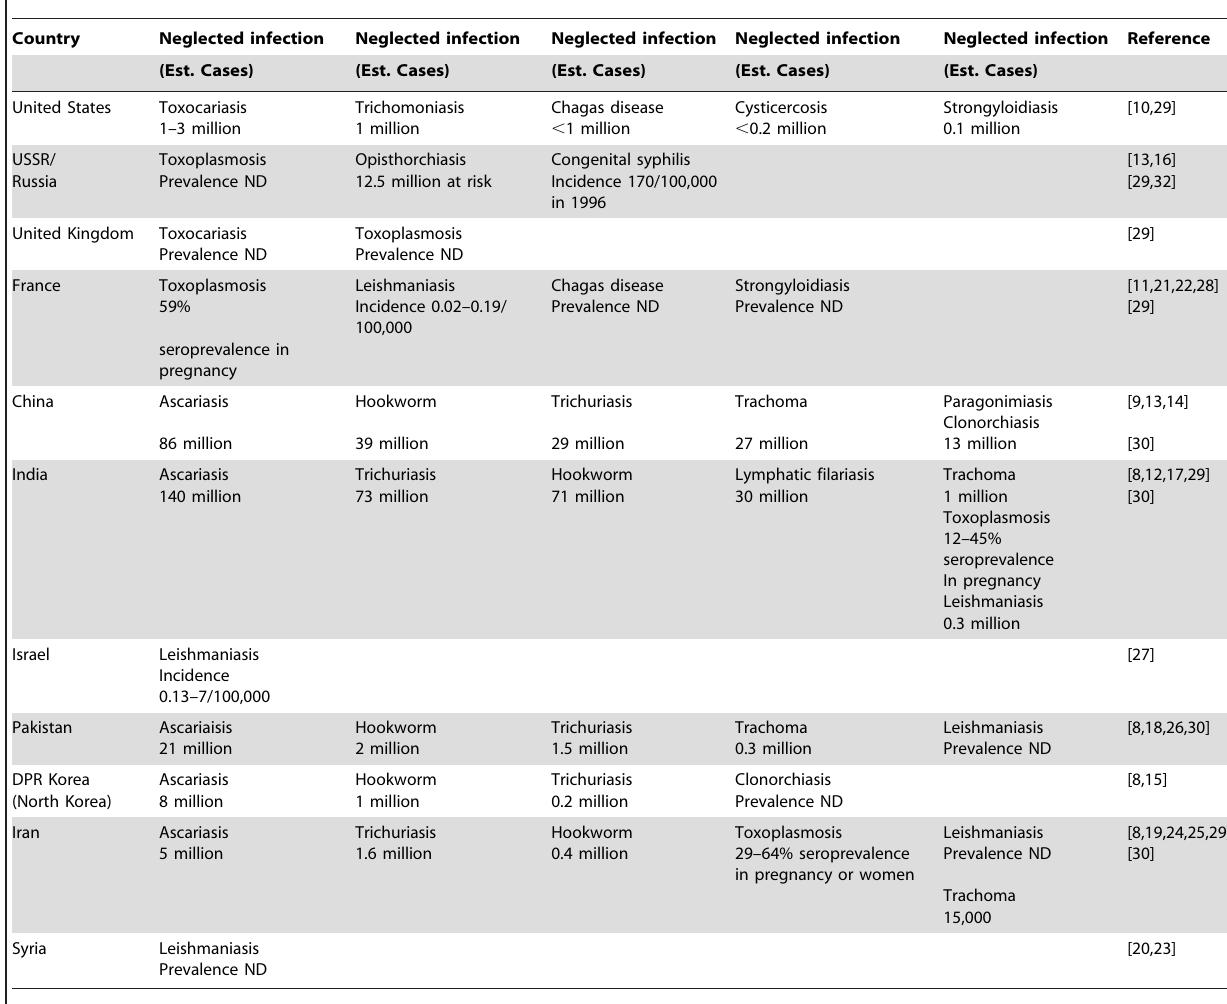
Table 2. The major neglected tropical diseases or neglected infection of poverty endemic to countries with nuclear weapons.